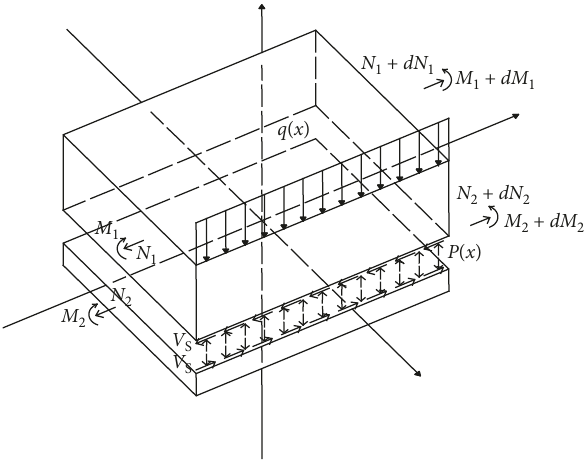
Figure 1: The isolation unit of the thin-layer beam.